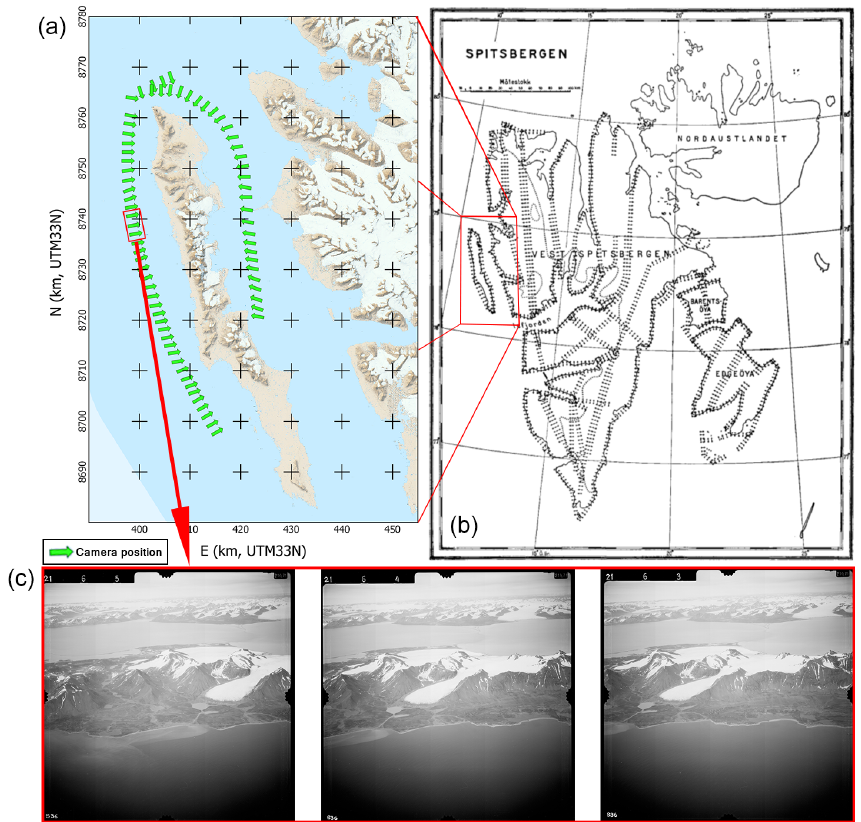
Figure 1. (a) Map of the example area with the positions of the camera and their pointing direction over Prins Karls Forland. (b) Map of Svalbard with the position of the images taken in 1936; from Luncke (1936). (c) Example of a triplet of images over Prins Karls Forland.